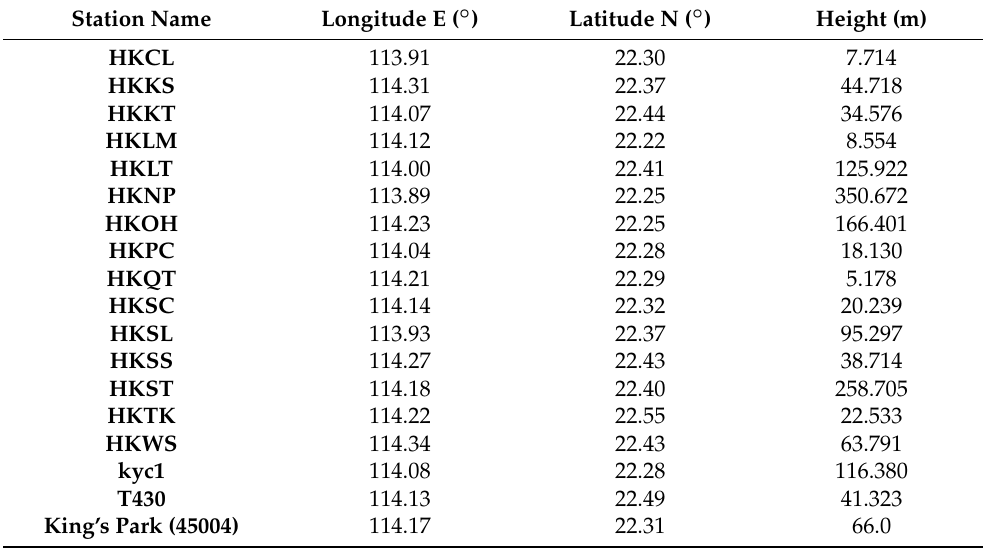
Table 1. GNSS stations and radiosonde station in HK selected for